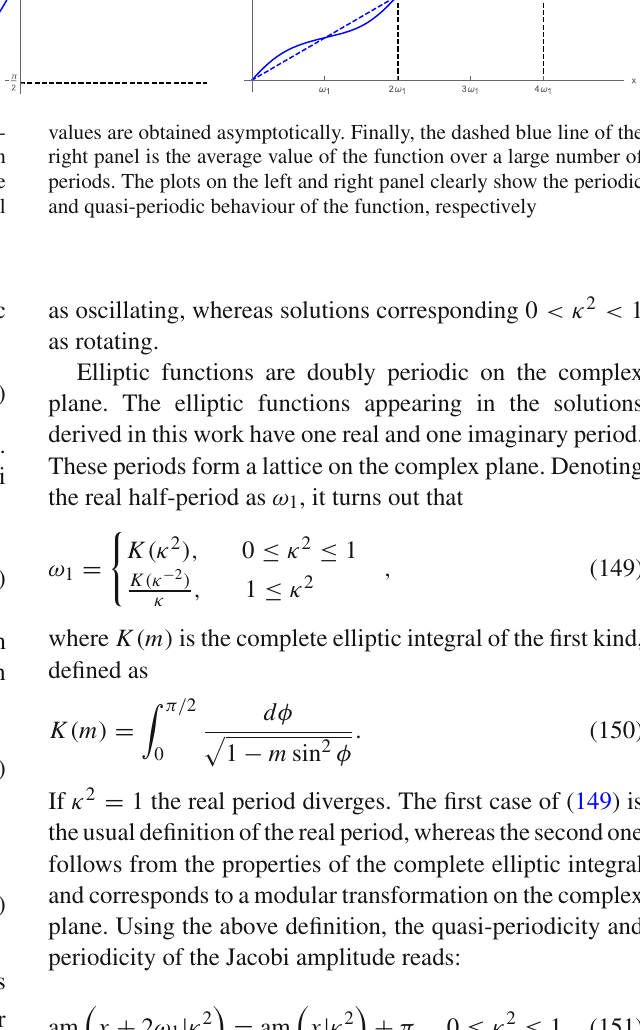
values are obtained asymptotically. Finally, the dashed blue line of the right panel is the average value of the function over a large number of periods. The plots on the left and right panel clearly show the periodic and quasi-periodic behaviour of the function,